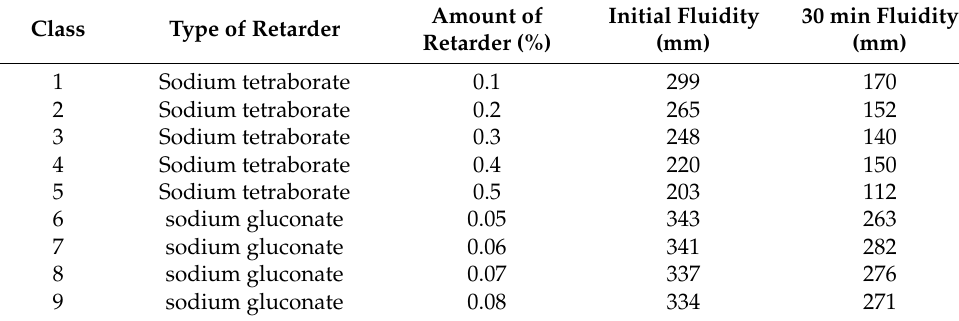
Table 8. Effect of retarder on fluidity of grouting